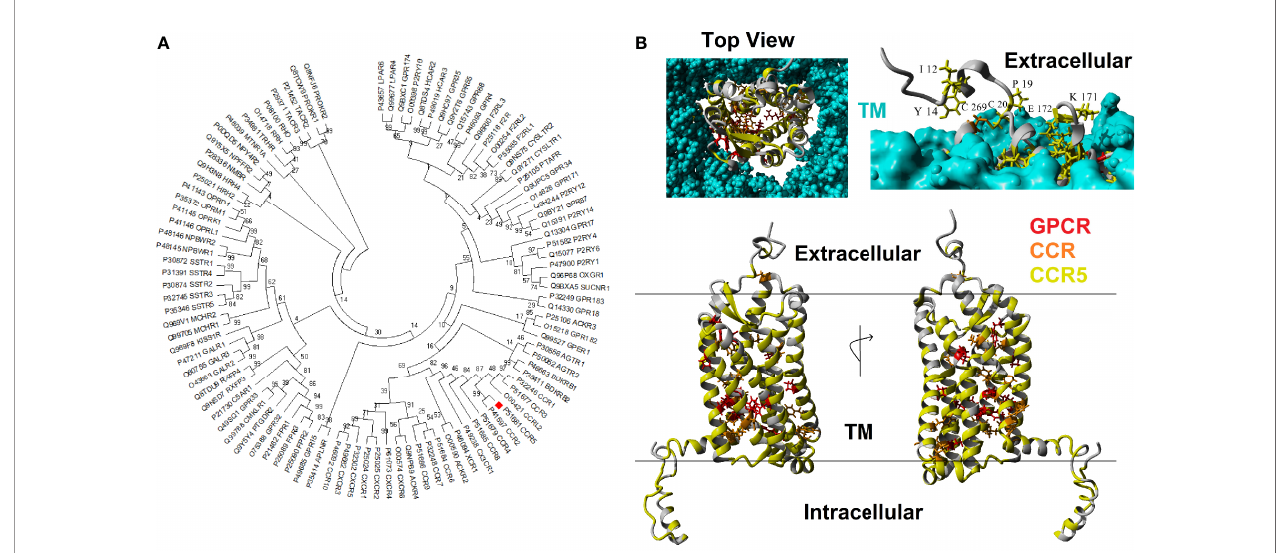
FIGURE 1 | Human CCR5 paralogs. (A) Phylogenetic tree of the top 100 human paralogs for CCR5 protein. Values at each node represent the percent of trees that cluster out of 500 bootstrap analyses. CCR5 is marked with a red box. (B) Model of human CCR5 with conservation colored. The transmembrane is colored cyan, amino acids conserved >90% in 100 GPCRs in red, conserved >90% in 16 most related CCR5 paralogs in orange, and conserved >90% in CCR5 vertebrate orthologs in yellow. The top left shows the view of CCR5 from extracellular space looking into the GPCR. The top right shows the side view with the transmembrane to visualize exposed and conserved residues, which are labeled. The bottom shows a 180° rotation of side view of